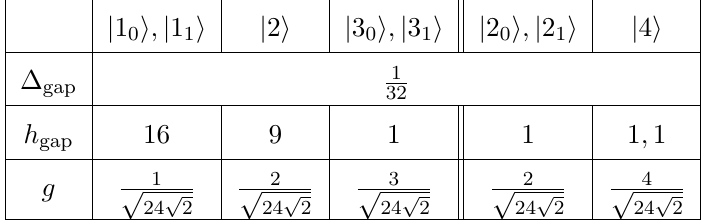
Table 4. Stable rational branes in the SU(2) 1 /S 4 orbifold CFT. The notations are parallel to that in table 3.